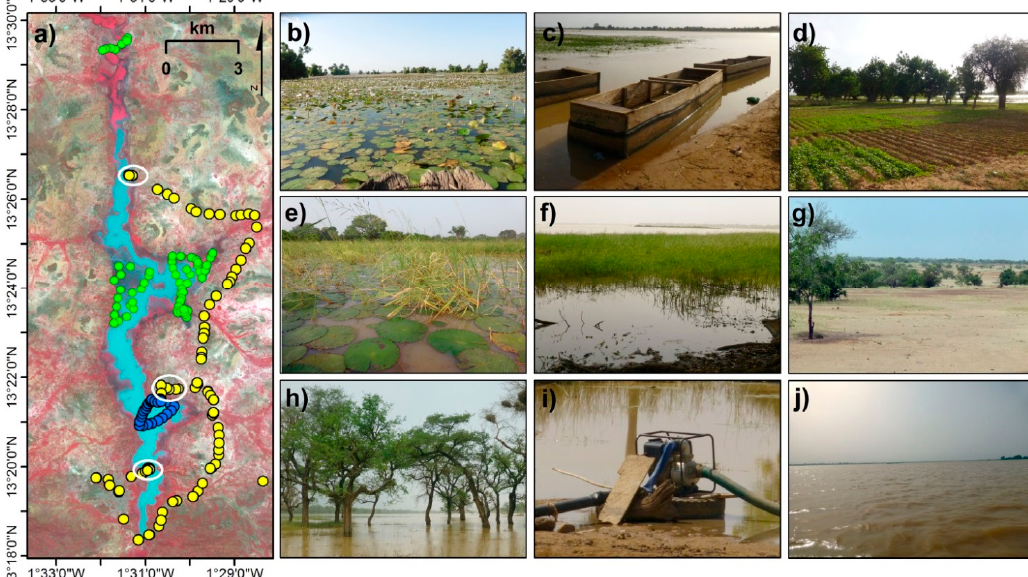
Figure 2. ( a ) Location of the GPS data (from 15–18 October 2013 to 25–28 October 2015) with the RapidEye image from 19 October 2013 as backdrop (©BlackBridge 2013, Berlin, Germany), including areas visited in greater detail (white circles), GPS/photo points on land (yellow dots), GPS/photo points from the boat tracks on the open water (blue dots), and on water with flooded vegetation (green dots); ( b ) floating water lilies; ( c ) shoreline including soil exposed after water retreat and flooded vegetation in the background; ( d ) irrigated fields; ( e ) flooded and floating vegetation; ( f ) water, flooded vegetation, and an island in the background, seen from the eastern shoreline; ( g ) barren land; ( h ) flooded trees next to the dam in the south; ( i ) motor pump at the shoreline; ( j ) open water seen from the boat southwards, (photos by L. Moser, F. Betorz Martìnez, R. Ouedraogo).